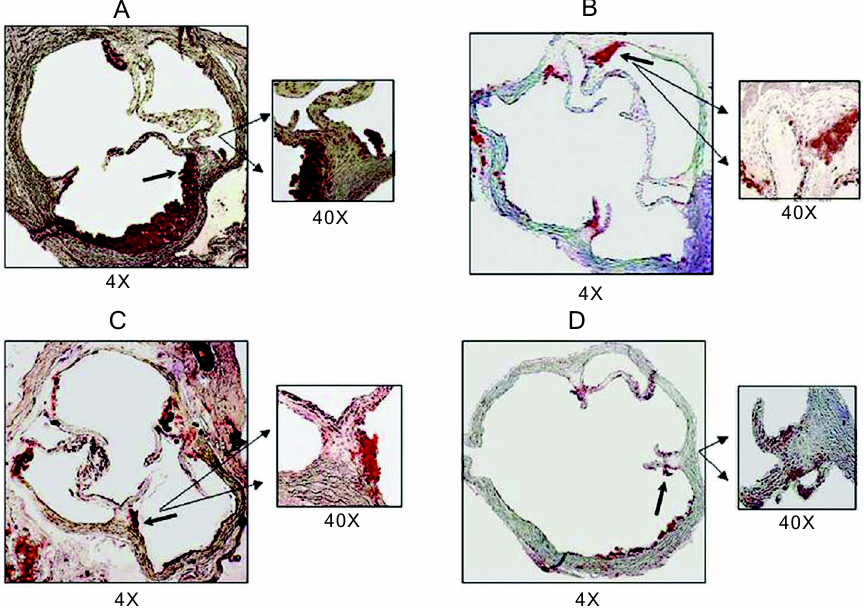
Figure 3. Immunohistochemistry staining of vascular cell adhe- sion molecule-1 (VCAM-1) in sections of the aorta of low-density lipoprotein receptor-deficient (LDLr-/-) mice not treated or treated with irrelevant monoclonal antibody (MAb, 100 µg), anti-LDL(-) MAb (100 µg), rabbit anti-LDL(-) polyclonal antibody (100 µg) or Fab fragments from rabbit anti-LDL(-) polyclonal antibody (100 µg). Percent of VCAM-1-positive staining on aorta sections was evaluated using image-analyzing software (KS300, Kontron). P < 0.05, ANOVA followed by the Tukey-Kramer test.